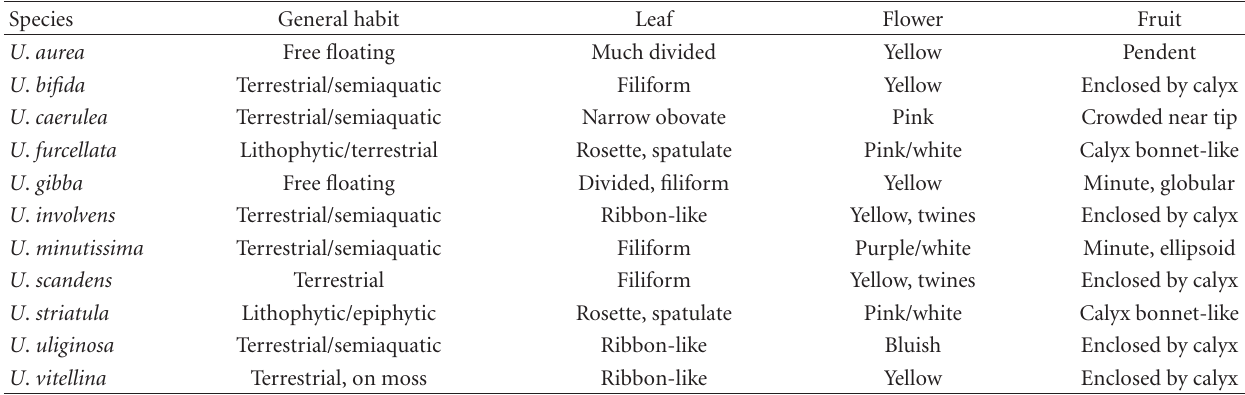
Table 1: General habit of Peninsular Malaysian Utricularia found in mountainous sites.